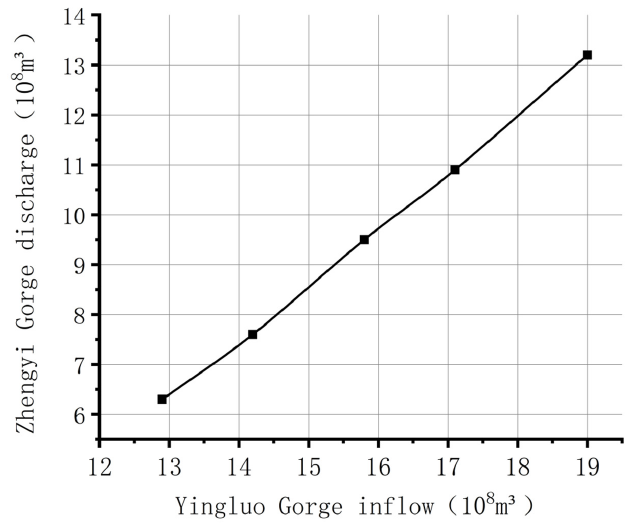
Figure 3. 97 Water Diversion Scheme.